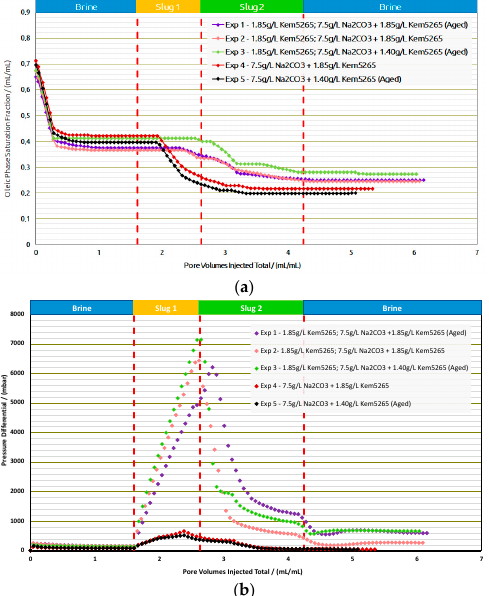
Figure 14. Oleic-phase saturation fraction/Pressure differential versus pore volumes injected total for the different slugs for core floods in Berea outcrops. ( a ) Reduction in oleic-phase saturation versus PV of slugs injected in Berea outcrops with crude dead oil initialization. ( b ) Pressure variation versus PV of injected slugs in Berea outcrops with dead oil initialization.